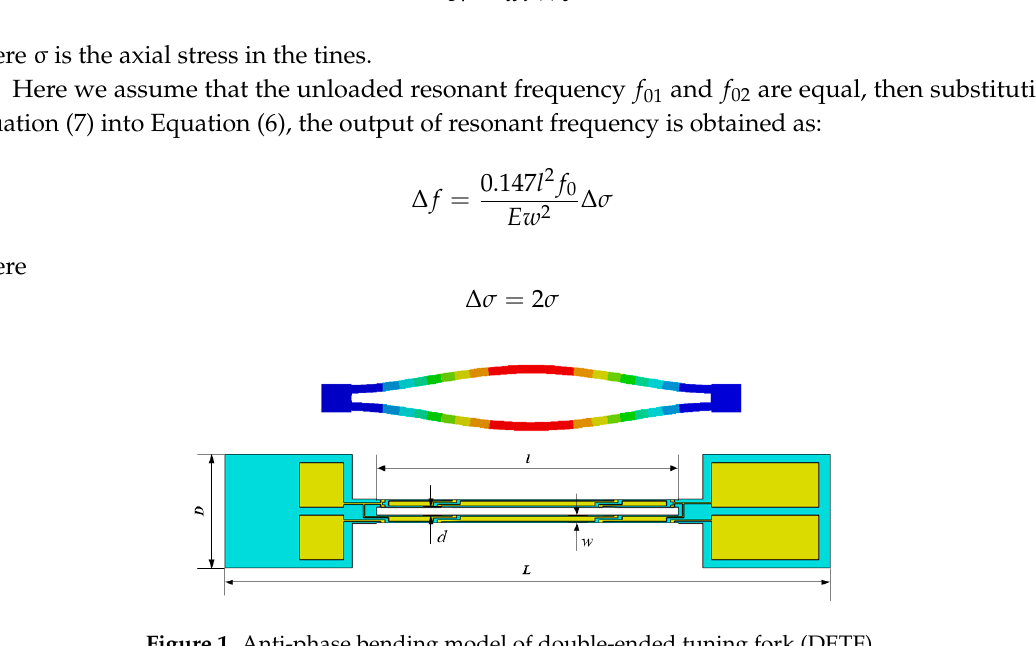
Figure 1. Anti-phase bending model of double-ended tuning fork (DETF).